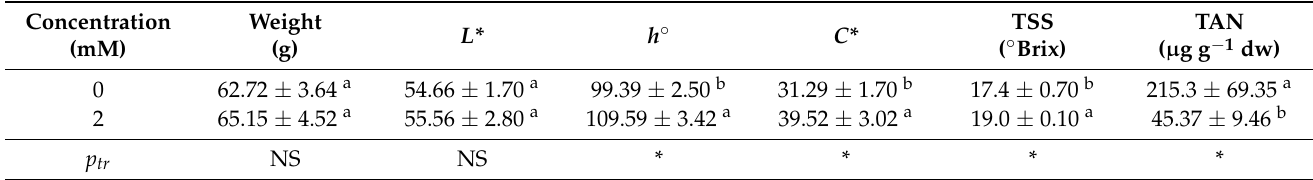
All data presented are means ± standard deviation (n = 3). Values with different letters showed statistically significant differences ( α = 0.05) according to Tukey-HSD test. *, p < 0.05; NS, non-significant.